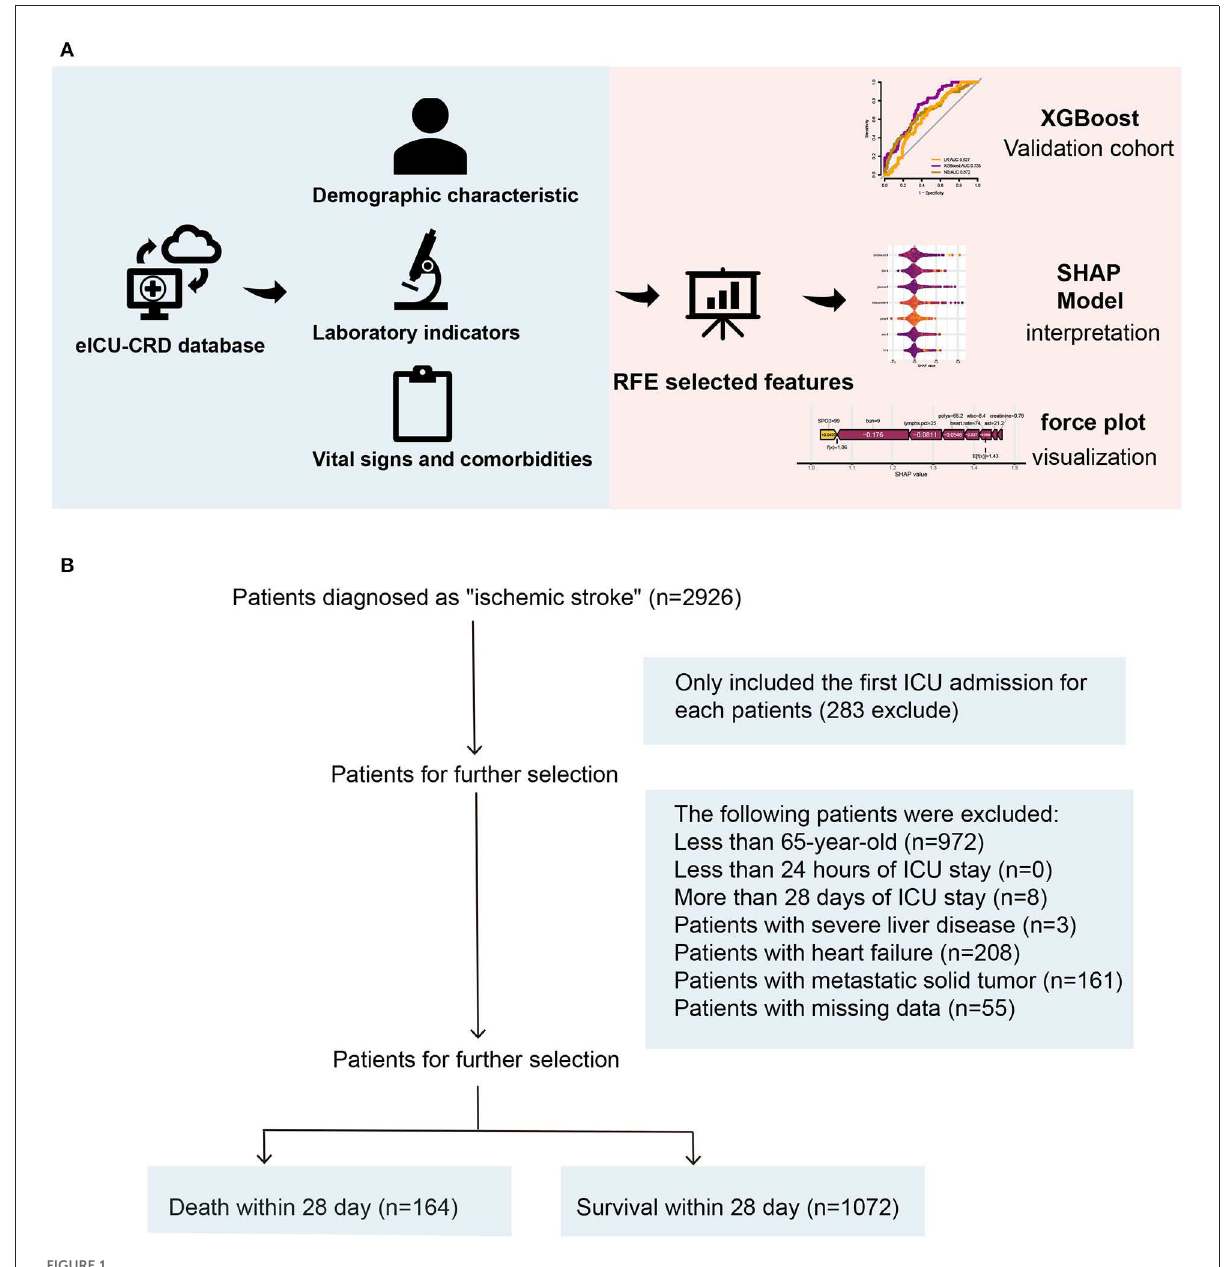
FIGURE1 (A, B) An overview of the variable selection process for the ML model. ML, machine learning.